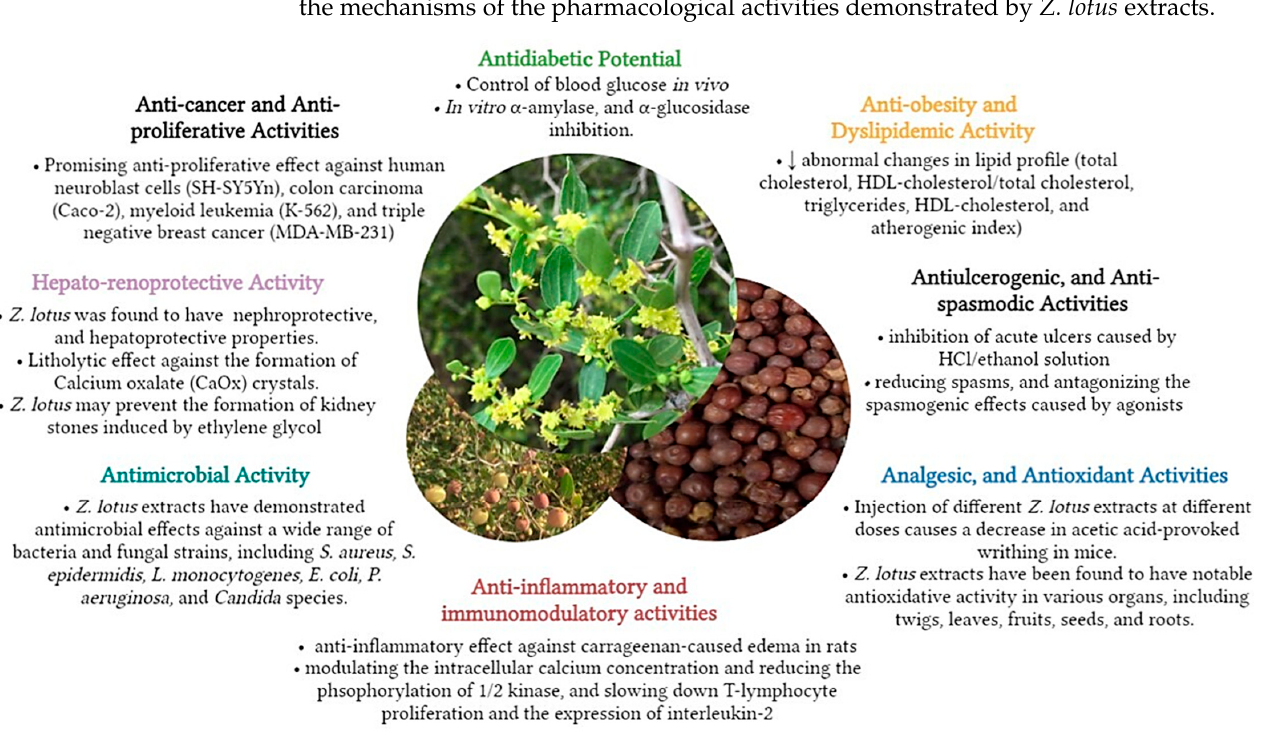
Figure 7. Comprehensive summary of the pharmacological activities of Z. lotus .